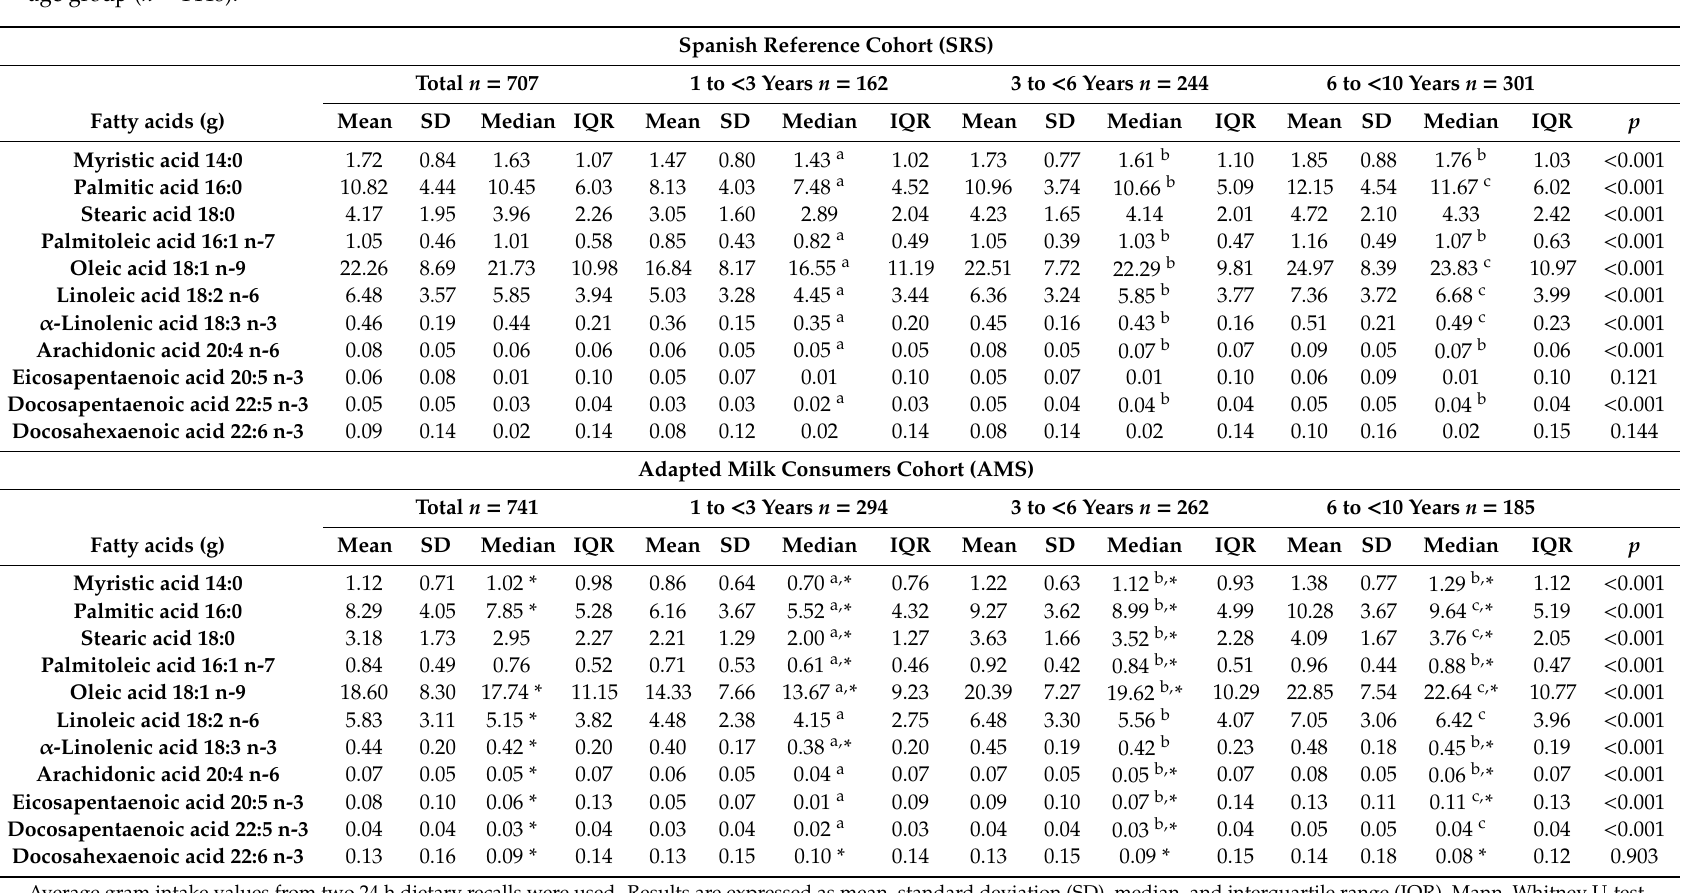
Table 6. Intake of major fatty acids from two 24 h dietary recalls from two cohorts of the Nutritional Study in the Spanish Pediatric Population (EsNuPI) according to age group ( n =